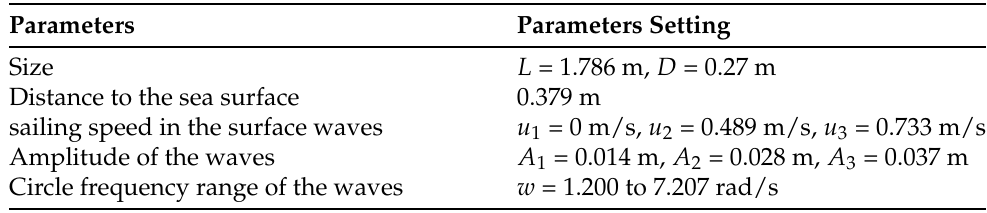
Table 6. Parameters of the 21UUV and the reported experiment.